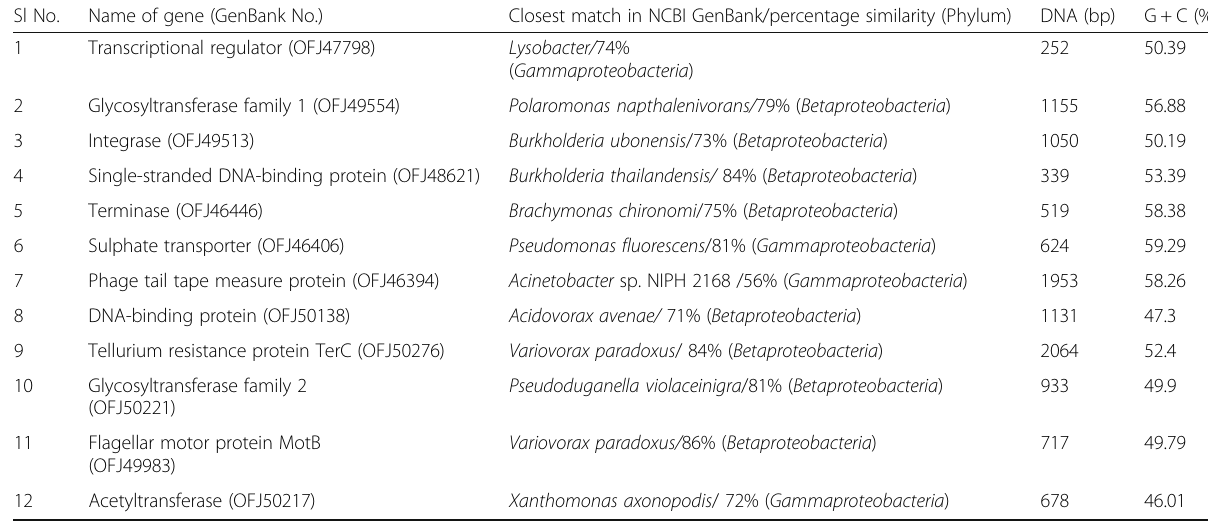
Table 6 Putative horizontally acquired genes of strain ERGS5:01; their closest match, gene length and G + C% composition Sl No. Name of gene (GenBank